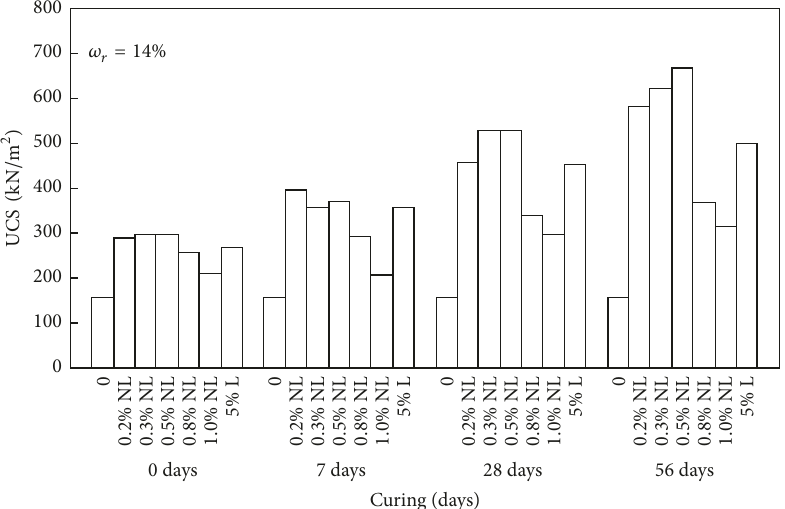
Figure 4: UCS development over curing periods for original soil, soil-nanolime mixtures, and soil-lime mixture at remolded water content of 14%.